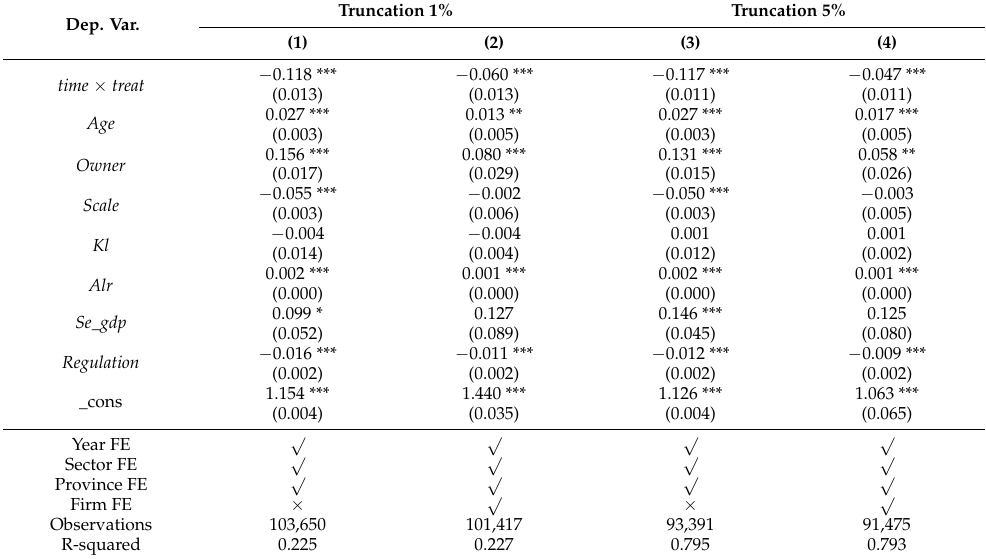
Table 6. Screening sample. Dep. Var.